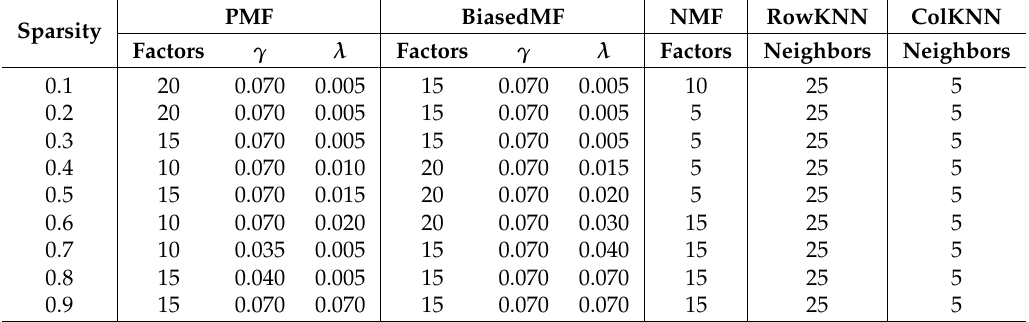
Table 1. Most adequate hyper-parameters reported by a grid search optimization on the [39] dataset. PMF BiasedMF Sparsity